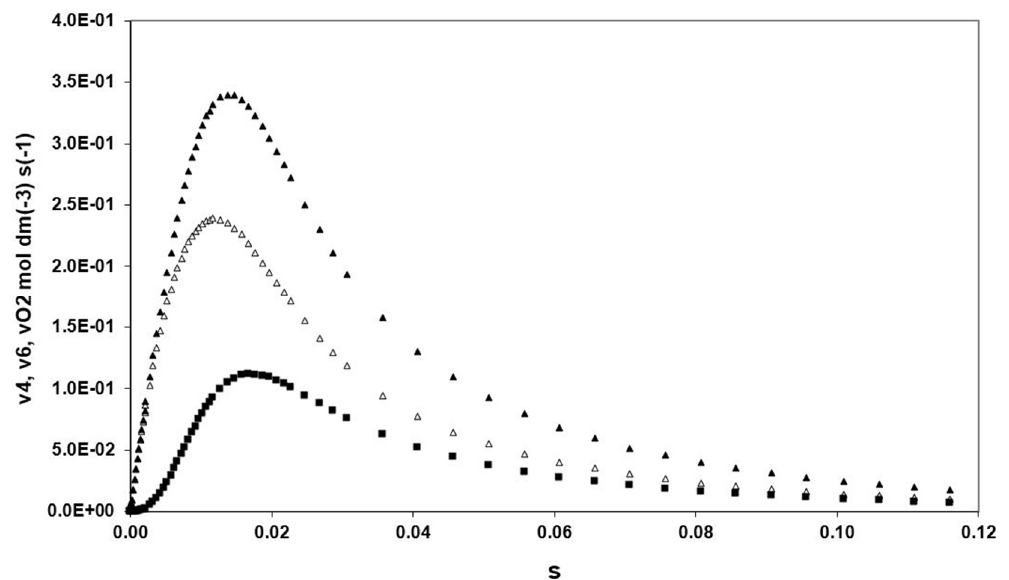
Figure 7. Resolution of the rate of O 2 evolution into H 2 O 2 and Fe 3+ dependent components. v 4 (empty triangles); v 6 (full squares); v O (full triangles); [H 2 O 2 ] o = 2 mol dm − 3 ; Other parameters as in Figure 2.